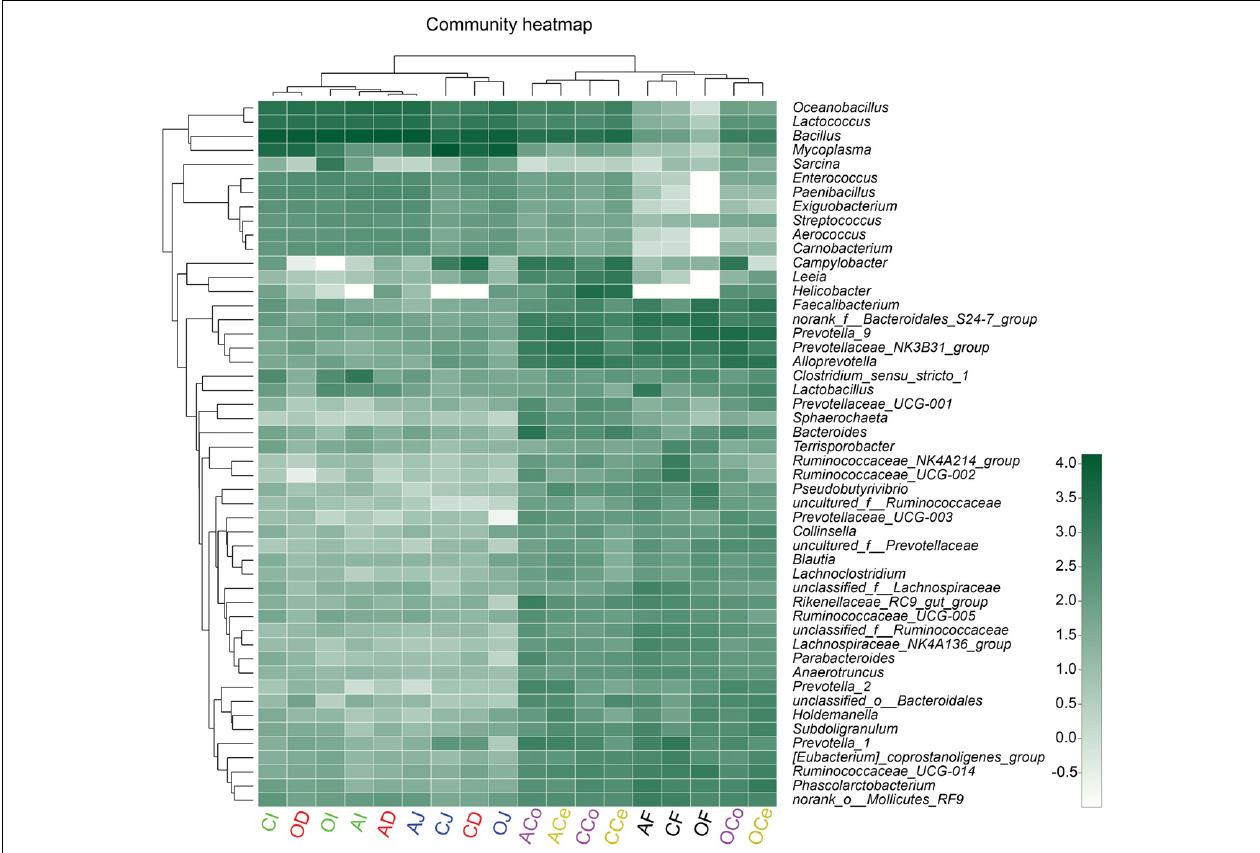
FIGURE 5 | Heatmap of the microbiota composition in the gut and feces microbiota at the genus level. The relationship among species is determined by the complete clustering method with Bray–Curtis distance. The top tree showed the clustering relationship of samples. In the heatmap, green color means higher relative abundance whereas white color signifies lower relative abundance. CD, AD, and OD: duodenum mucosal microbiota of control group, alfalfa meal group, and commodity concentrated fiber group, respectively. CJ, AJ, and OJ: jejunum mucosal microbiota of control group, alfalfa meal group, and commodity concentrated fiber group, respectively. CI, AI, and OI: ileum mucosal microbiota of control group, alfalfa meal group, and commodity concentrated fiber group, respectively. CCe, ACe, and OCe: cecum mucosal microbiota of control group, alfalfa meal group, and commodity concentrated fiber group, respectively. CCo, ACo, and OCo: colon mucosal microbiota of control group, alfalfa meal group, and commodity concentrated fiber group, respectively. CF, AF, and OF: feces mucosal microbiota of control group, alfalfa meal group, and commodity concentrated fiber group,